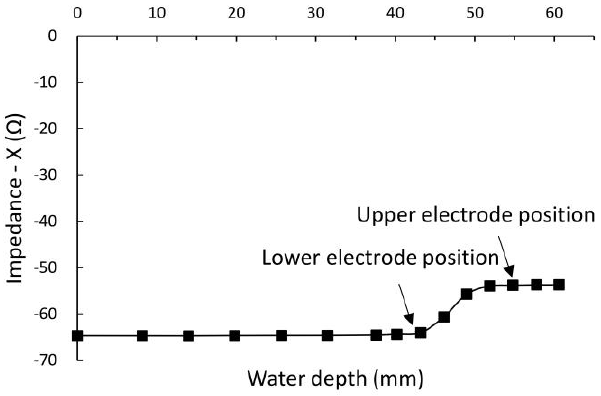
Figure 7. Results of measurement of the vertical effective depth of the electrode’s electric field.